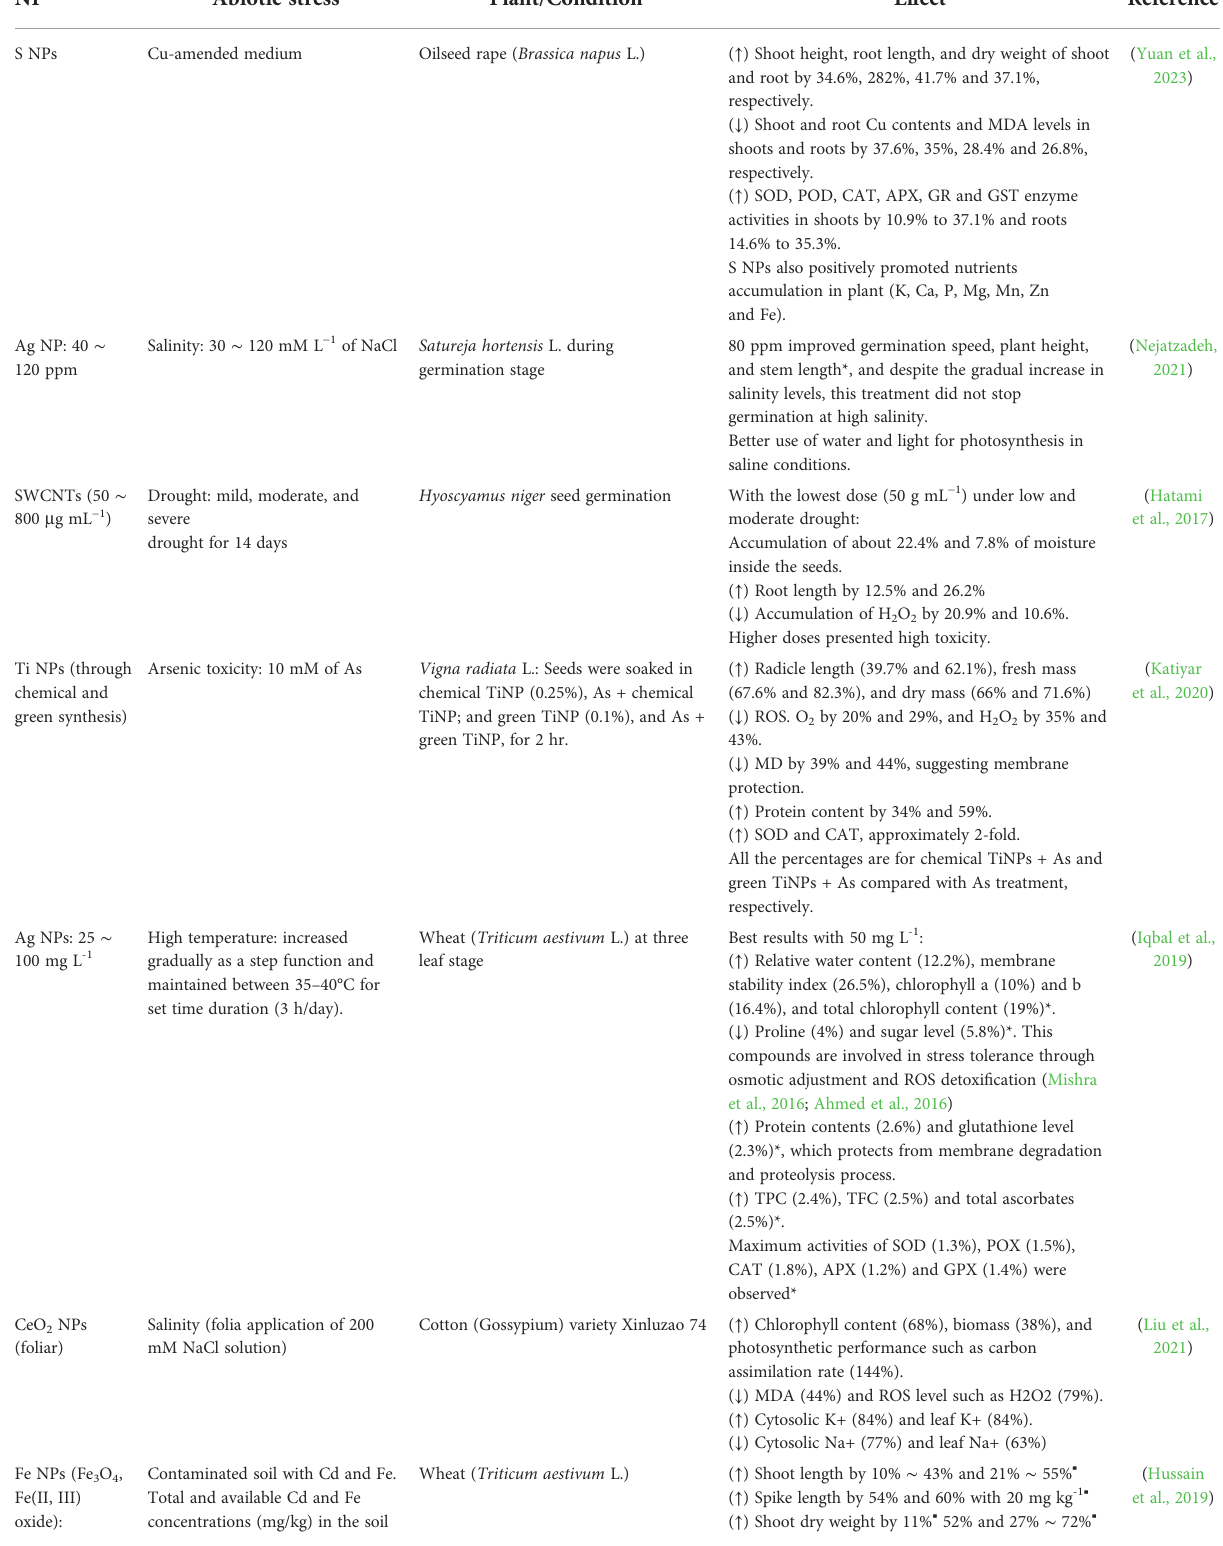
TABLE 3 Effect of several NPs on plant abiotic